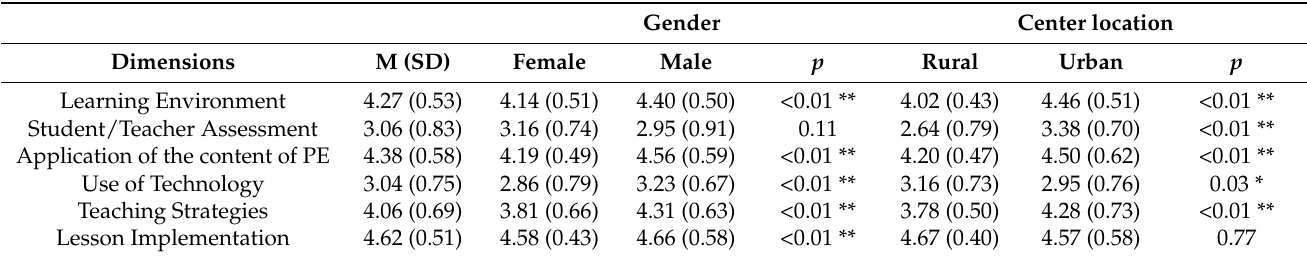
Table 3. Differences in SETEQ-PE dimensions according to gender and center location.